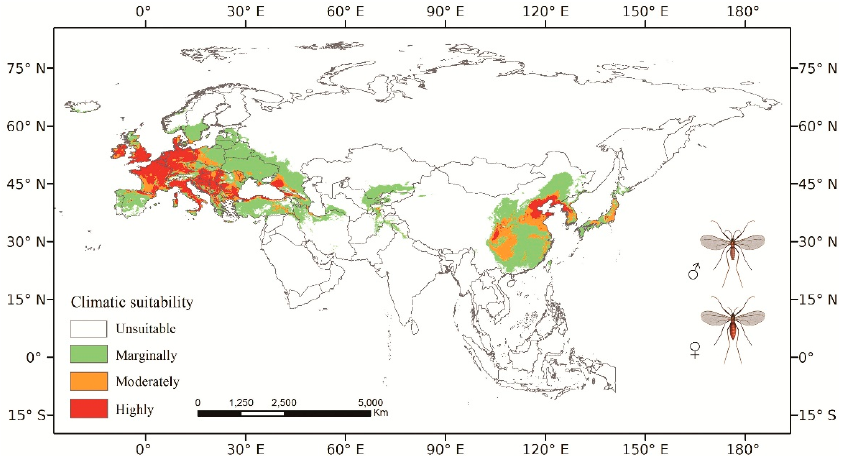
Figure 1. Prediction of the current potential distribution area of O. robiniae in Eurasia. Colors indicate the probability of climatic suitability: unsuitable area (0–0.043), marginally suitable area (0.043–0.4), moderately suitable area (0.4–0.6), and highly suitable area (0.6–1.0). Spatial resolution: 2.50 min; Geographic Coordinate System: WGS 84.